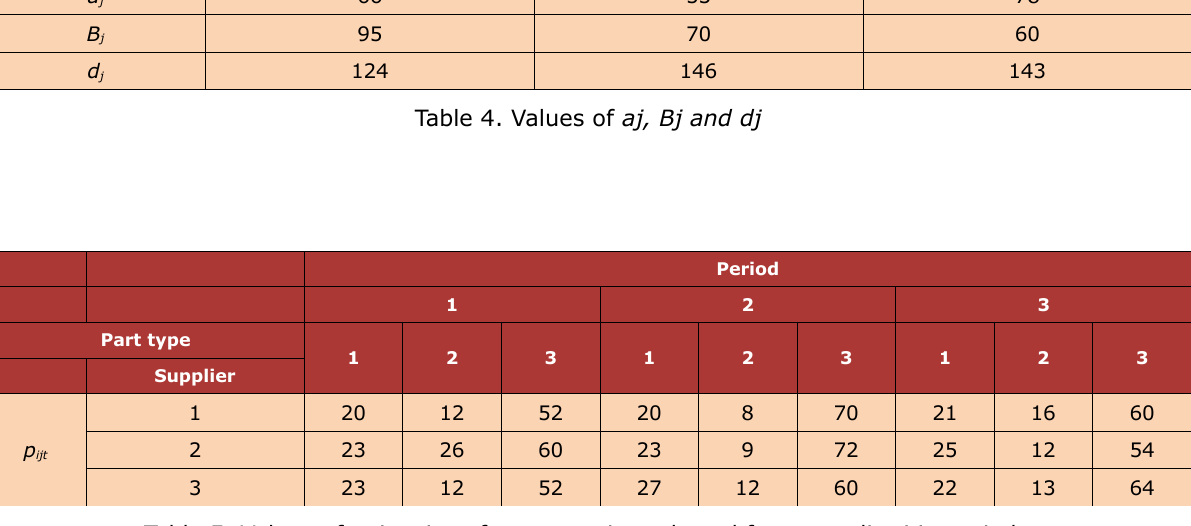
Table 5. Values of unit price of part type j purchased from supplier i in period